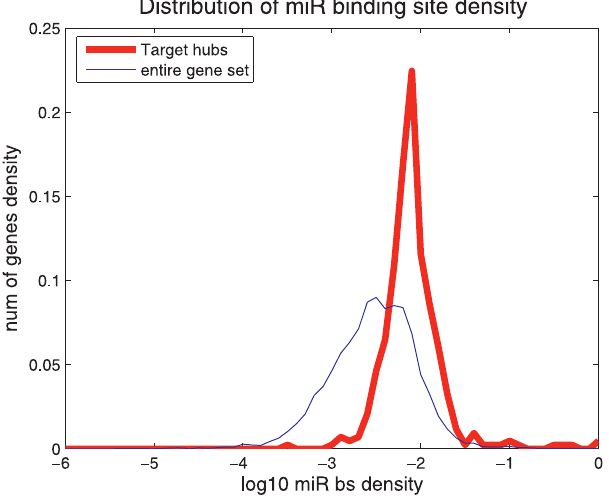
Figure 2. Distribution of the density of miRs in the 3 9 UTRs of target hubs (thick red line) and all the genes (thin blue line) in the TargetScan dataset (all genes included in this figures have at least one miR site predicted in their 3 9 UTR). The log10 densities were binned into bins of 0.1, and relative frequencies were plotted. Same analysis for the PicTar dataset is in Figure S2.